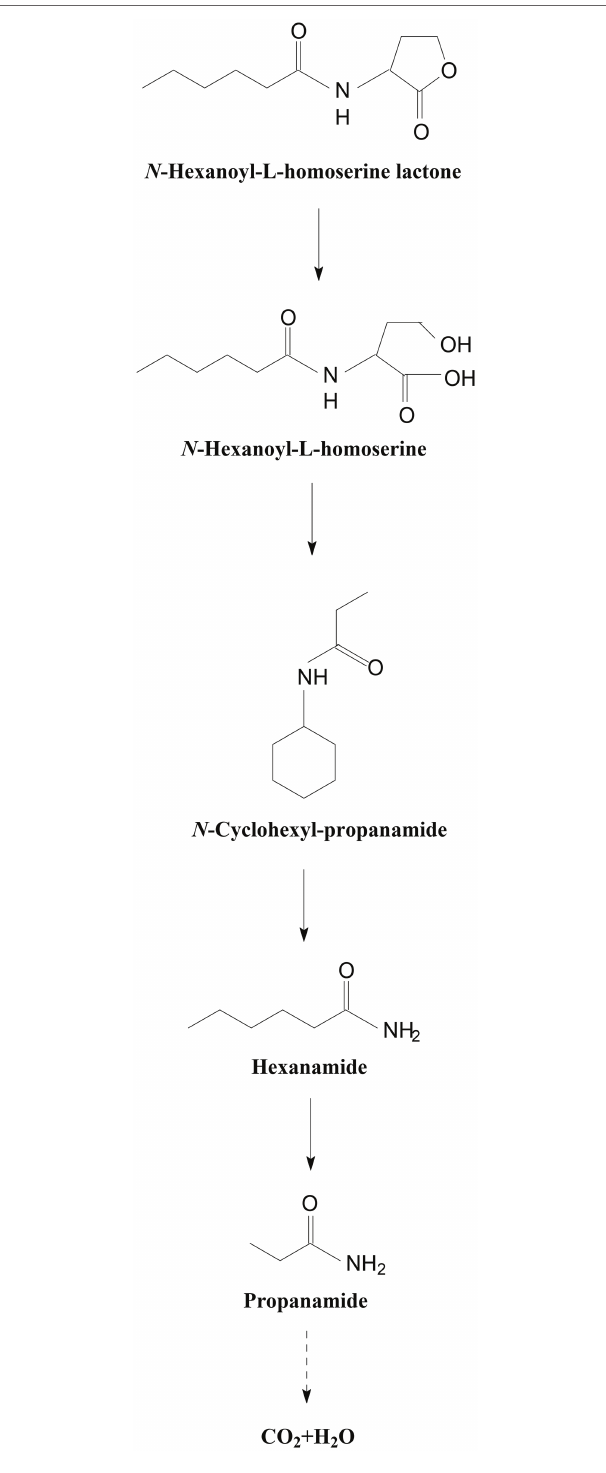
FIGURE 6 | Proposed AHL-degradation pathway in strain W-7. HHL was initially degraded by the hydrolysis of its ester ring to yield N -hexanoyl-l- homoserine, which can be further degraded into N -cyclohexyl-propanamide by breaking the carbon-nitrogen bond, and then degraded to form hexanamide and propanamide. Finally, HHL was degraded into carbon dioxide and water without any persistent accumulative